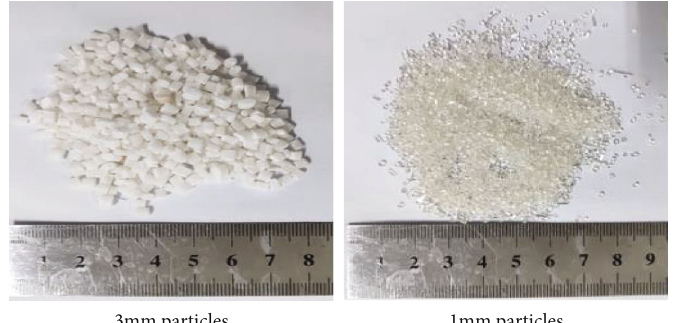
Figure 2: 3mm particles (left) and 1 mm particles